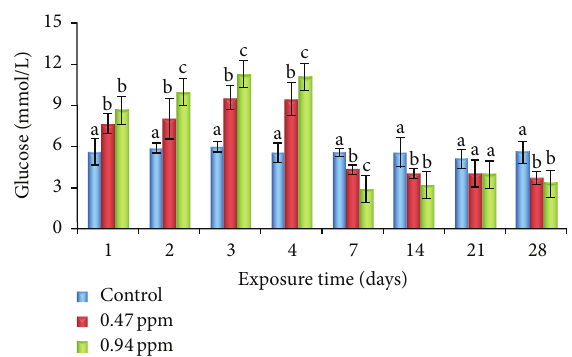
Figure 1: Effects of sublethal exposure of QP on glucose levels (Means ± SD) at different time intervals in silver barb. Different superscript alphabets are significantly different at 𝑝 < 0.05